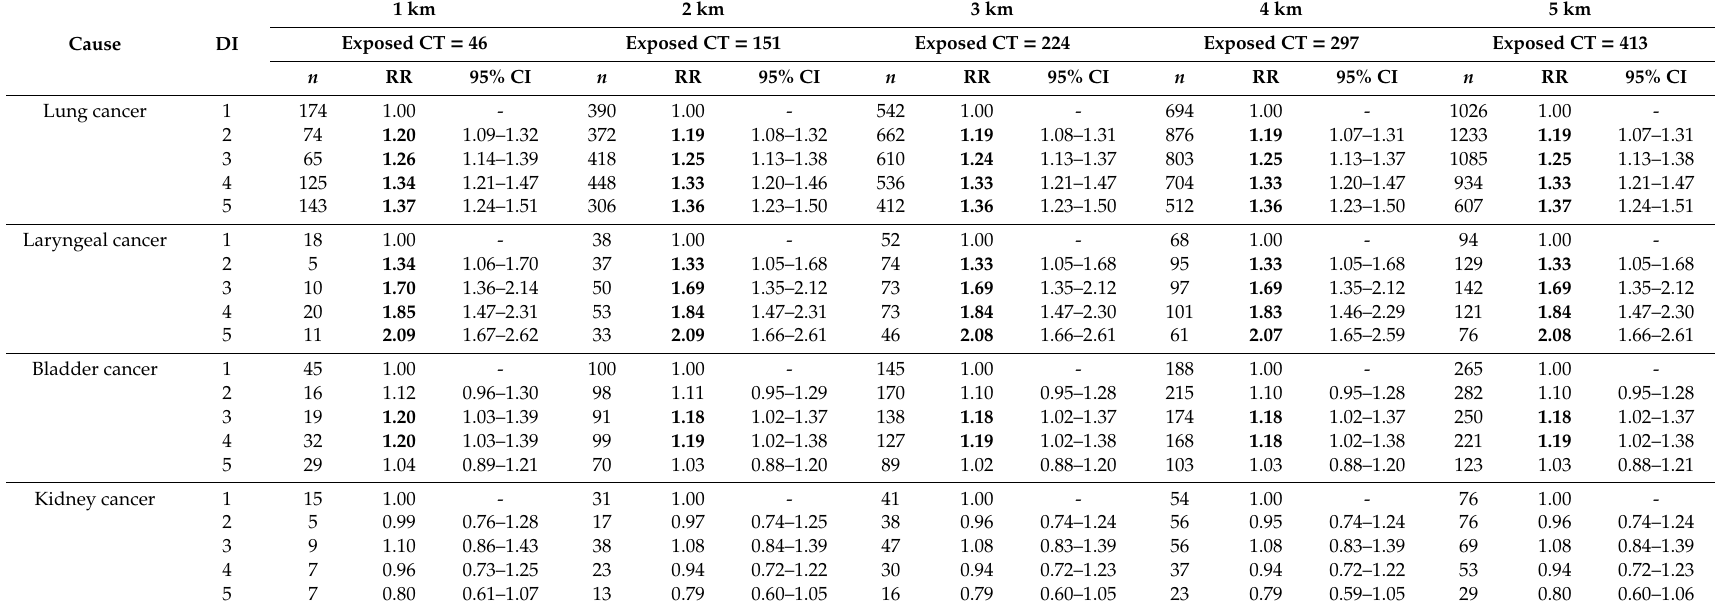
Table 1. Relative risks (RRs) for deprivation index adjusted for distance of exposure for the male